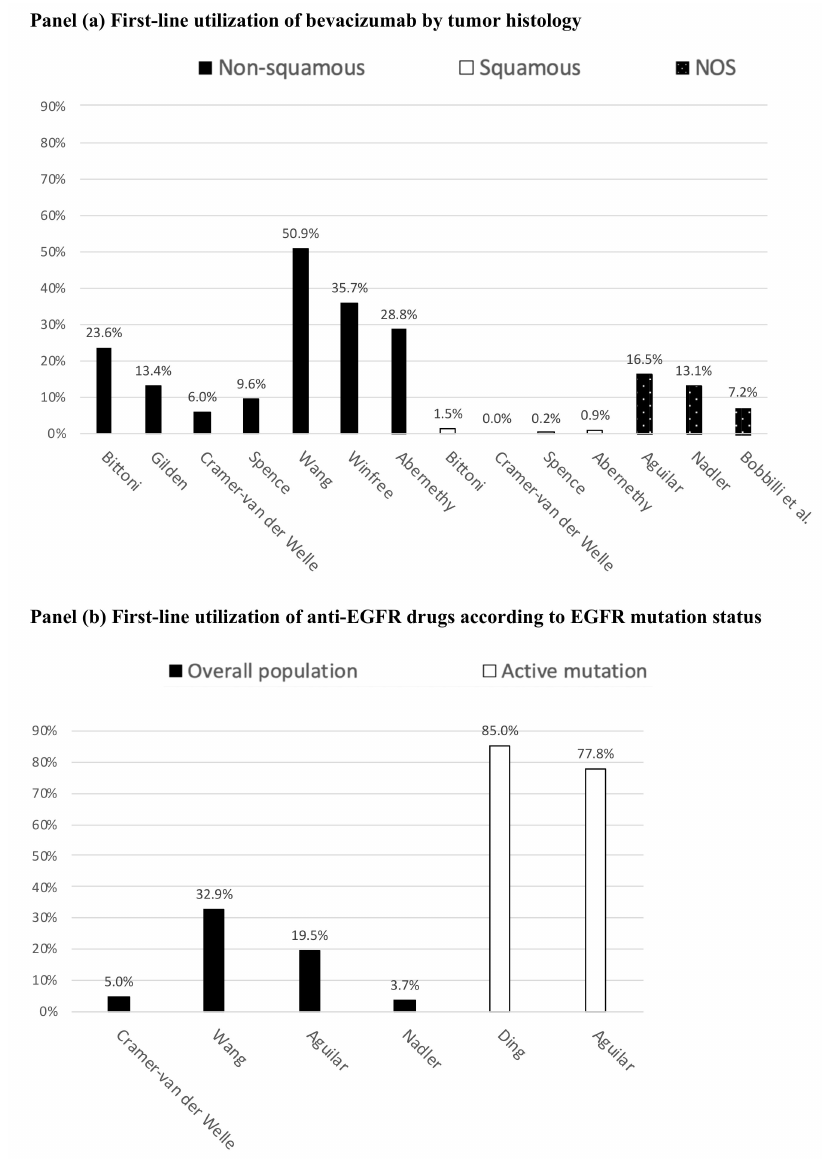
Figure 2. Reported incidence of use of innovative drugs as first-line pharmacotherapy for advanced non-small-cell lung cancers (NSCLC). ( a ) First-line utilization of bevacizumab by tumor histology; ( b ) First-line utilization of anti-EGFR drugs according to EGFR mutation status; NOS: not other- wise